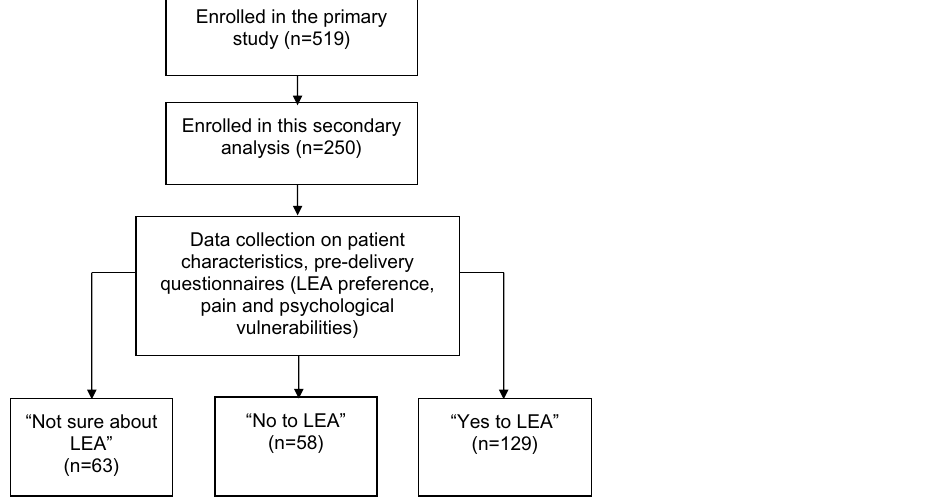
Figure 1. Study flowchart. LEA, labor epidural